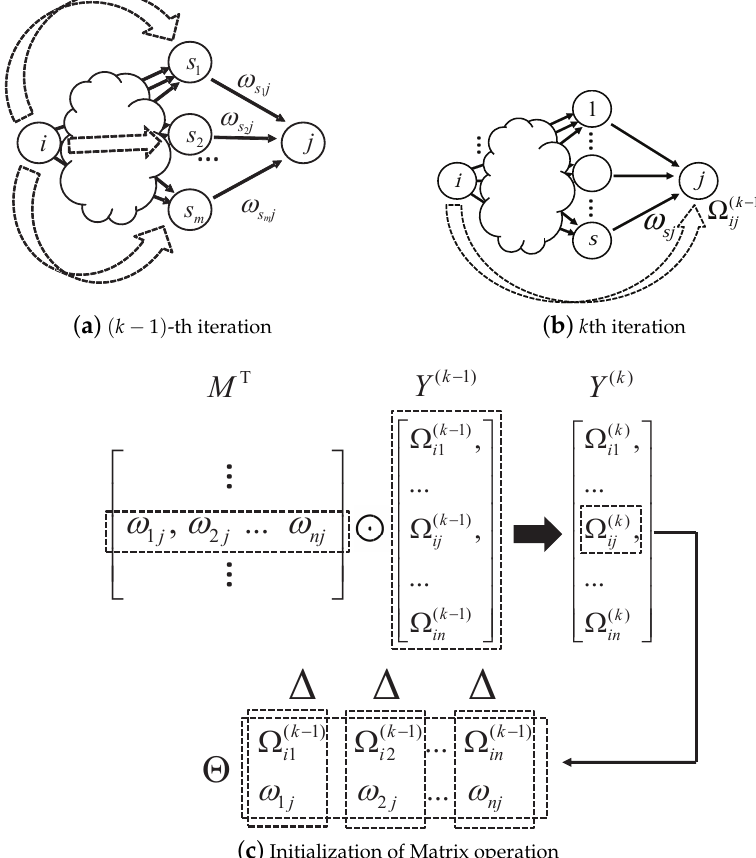
Figure 4. Matrix formation and initialization in TW route